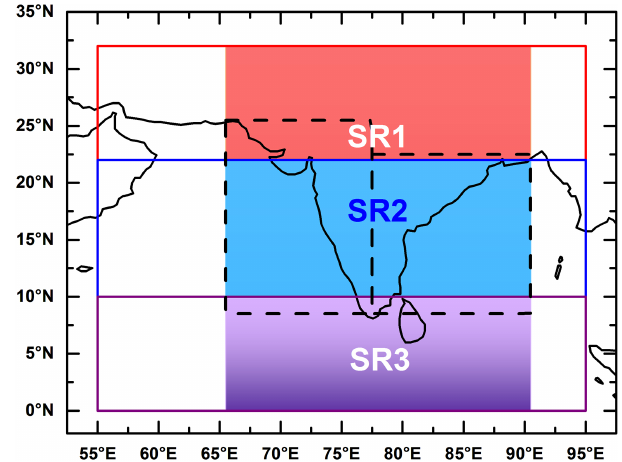
Figure 1. The study region is divided into three sub-regions. All the sub-regions cover the longitude range from 55 to 95 ◦ E. The lat- itude bands covered by the sub-regions SR1 (red), SR2 (blue), and SR3 (purple) are respectively 22–32, 10–22, and 0–10 ◦ N. The sub- regions are marked by the solid rectangular boxes. The aerosol SSA values have been estimated within the latitude band 65.5–90.5 ◦ E represented by the filled rectangular boxes within the sub-regions. The dashed rectangular boxes represent the regions selected for ex- tending the assimilated SSA to the oceanic region. The dashed rect- angular boxes on the western and eastern sides of peninsular India represent 8.5–25.5 ◦ N and 65.5–77.5 ◦ E and 8.5–22.5 ◦ N and 77.5– 90.5 ◦ E regions